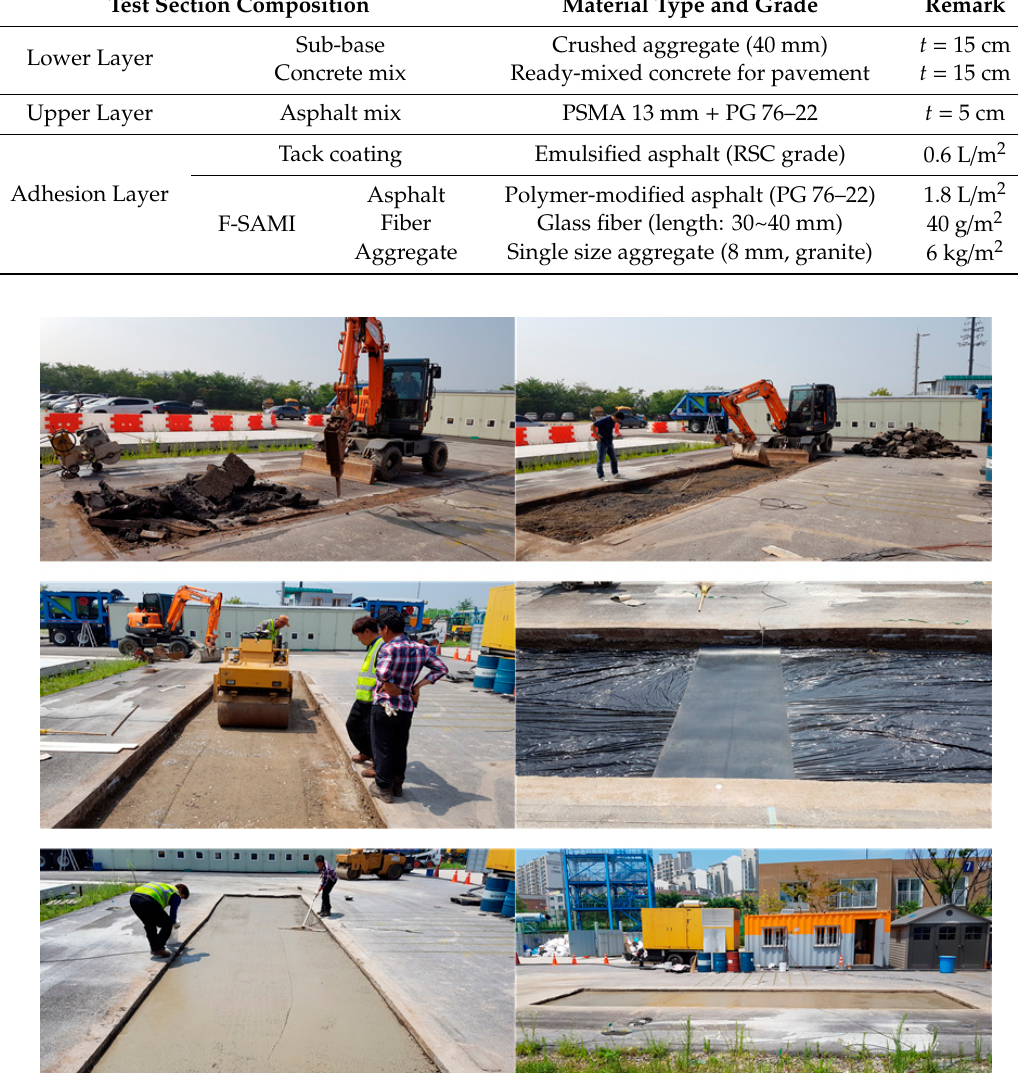
Figure 9. Construction for test section: upper layer. The APT test conditions applied to the F-SAMI, fiber-reinforced, stress-relief layer method test bed are as follows: